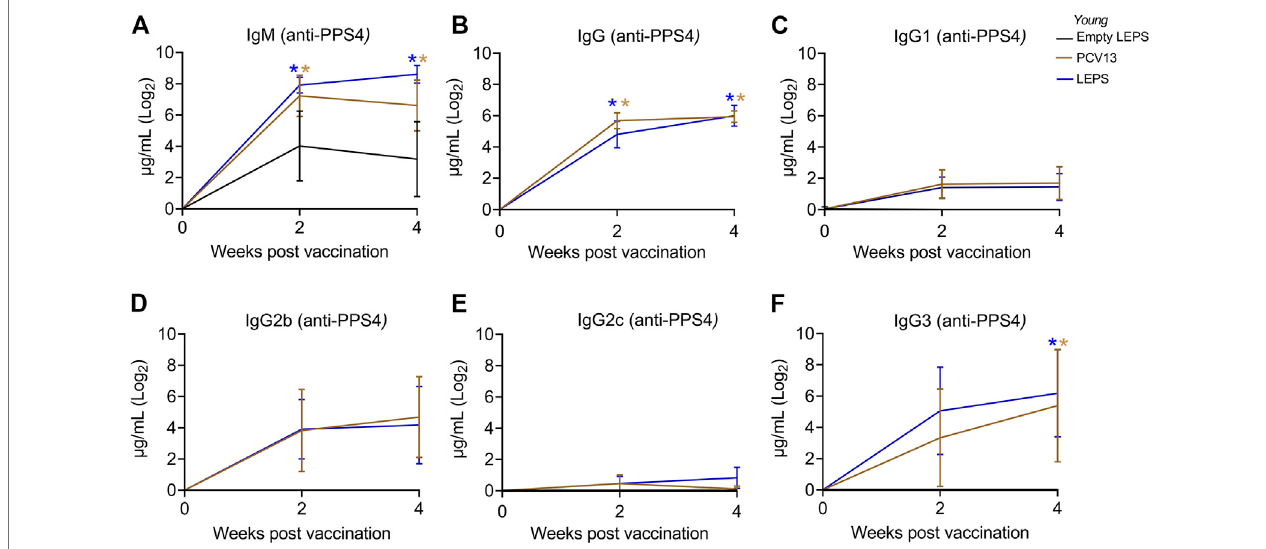
FIGURE 2 | The LEPS vaccine and Prevnar-13 induce comparable levels of antibodies against pneumococcal polysaccharides in young hosts. Young C57BL/6 mice(2-months)wereinjected i.m. withLEPScontainingserotype4capsularpolysaccharideantigen,PCV13,orthecontrols(ShamorEmptyLEPSvector)followingthe timelinein Figure1B .TotallevelsofIgM (A) ,IgG (B) ,and IgGsubtypes includingIgG1 (C) ,IgG2b (D) ,IgG2c (E) andIgG3 (F) againstpuri fi edpolysaccharideserotype4 in the sera were measured over time by ELISA. p values were determined by one-way ANOVA followed by Tukey ’ s test. Asterisks (* p < 0.05) denote signi fi cant differences between the indicated group and the empty LEPS group. Data shown are presented as mean ± CI and are pooled from 3 separate experiments with n (cid:2) 10 mice for Empty LEPS, n (cid:2) 10 mice for LEPS, and n (cid:2) 15 mice for the PCV13 groups.